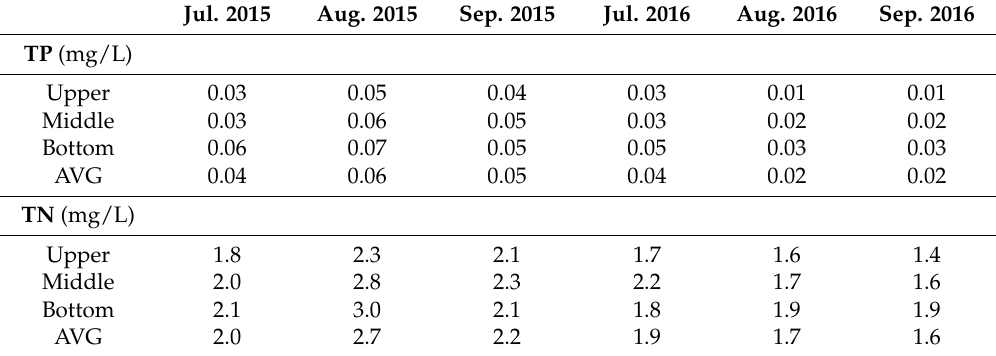
Table 2. Comparison of TP and TN concentrations (mg/L) in the studied area between 2015 and